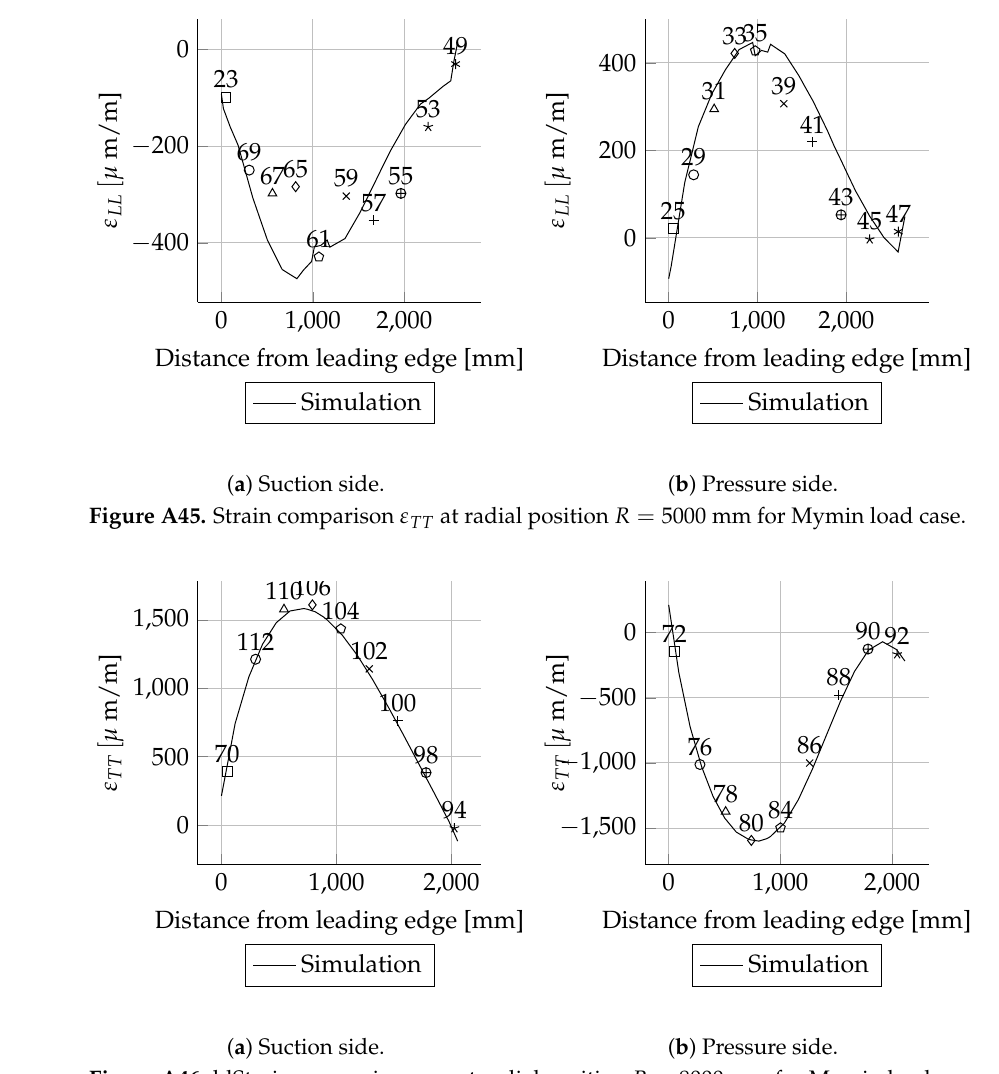
Figure A46. hlStrain comparison ε LL at radial position R = 8000 mm for Mymin load case.